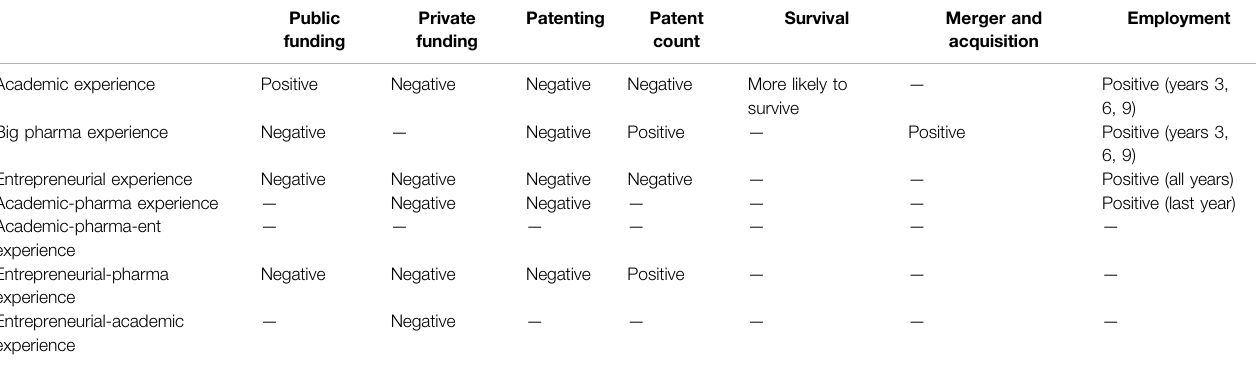
TABLE 2 | Summary Results of Donegan et al.